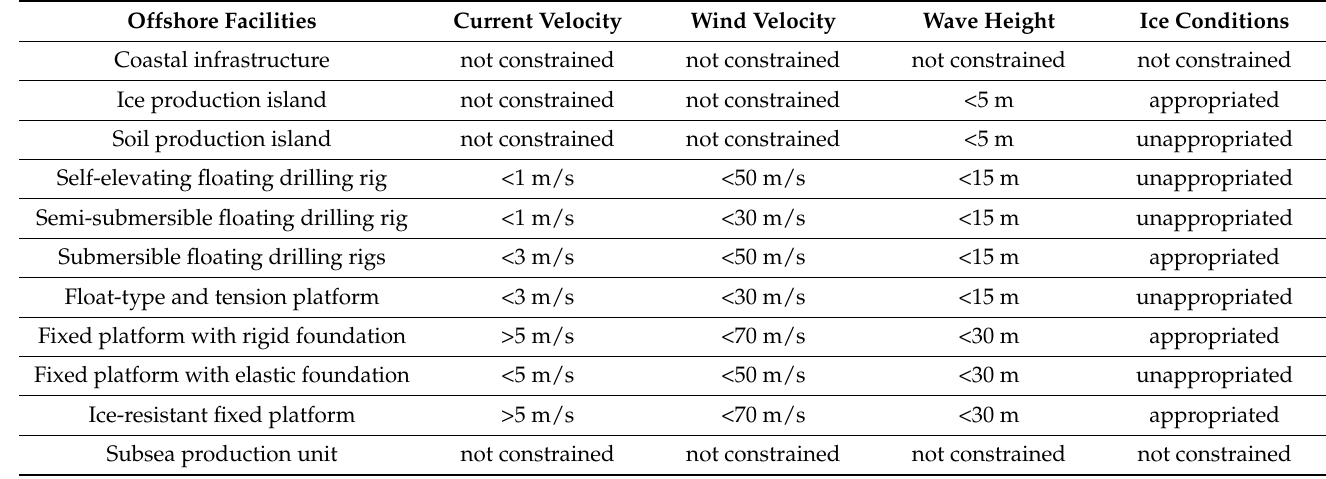
Table 2. The applicability analysis of offshore oil and gas facilities (hydrometeorological factor) [8–11].